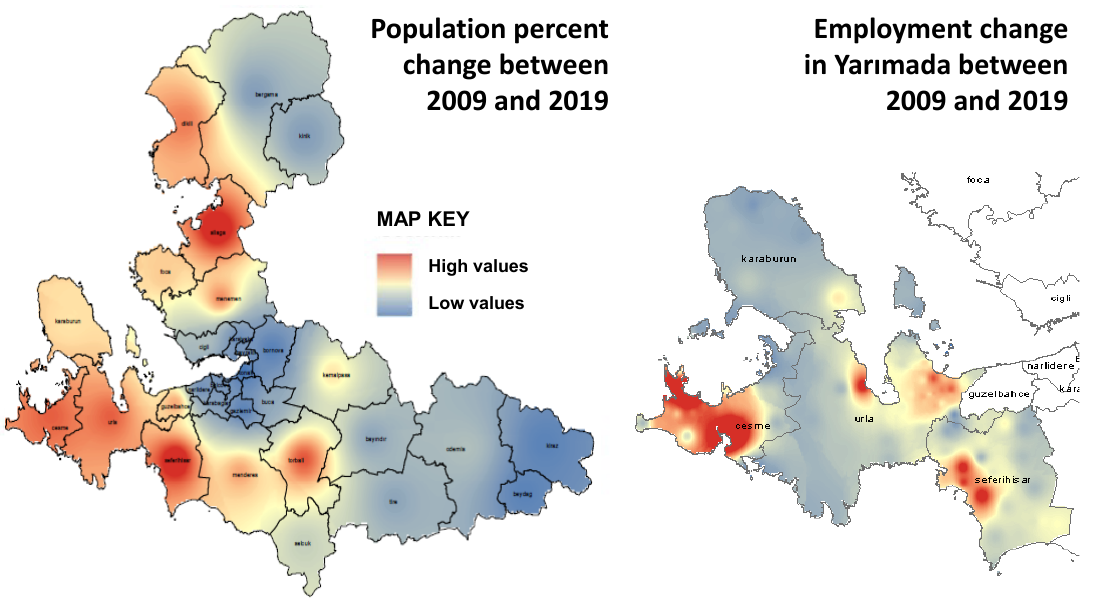
between 2009 and 2019